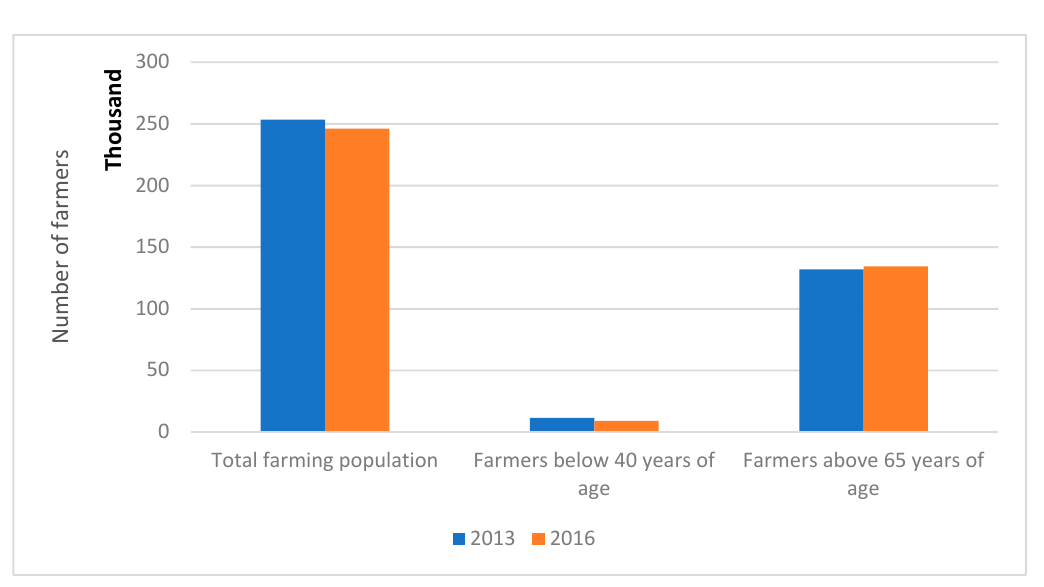
Figure 3. Distribution of farmers in Portugal by age during the period 2013–2016 [38,39].